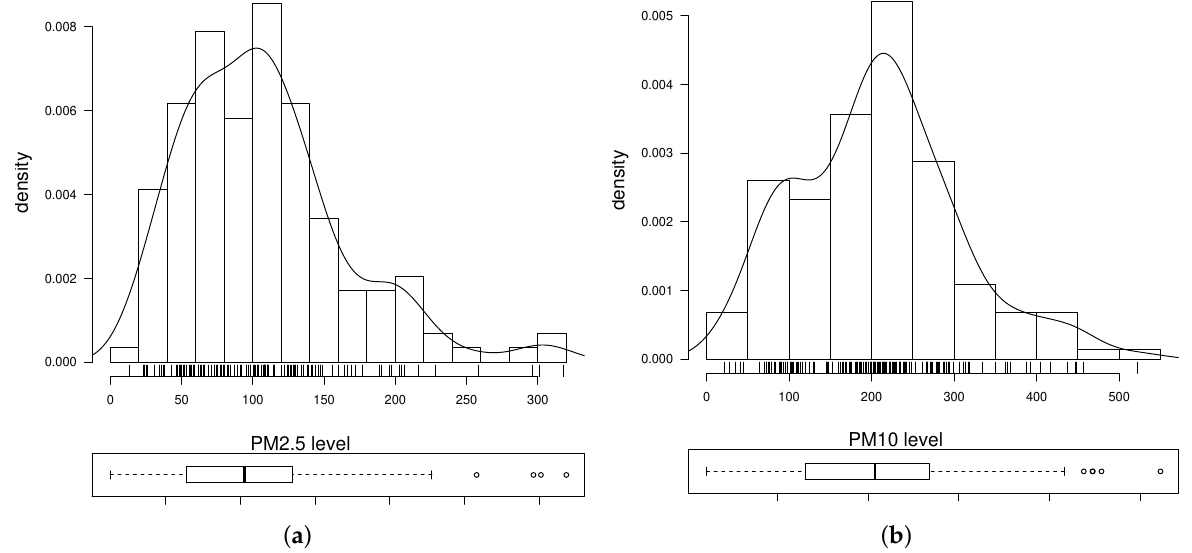
Figure 2. Histogram for Chilean PM data using PM2.5 ( a ) and PM10 ( b ) levels recorded by the Pudahuel monitoring station in Santiago, Chile, during 2015.